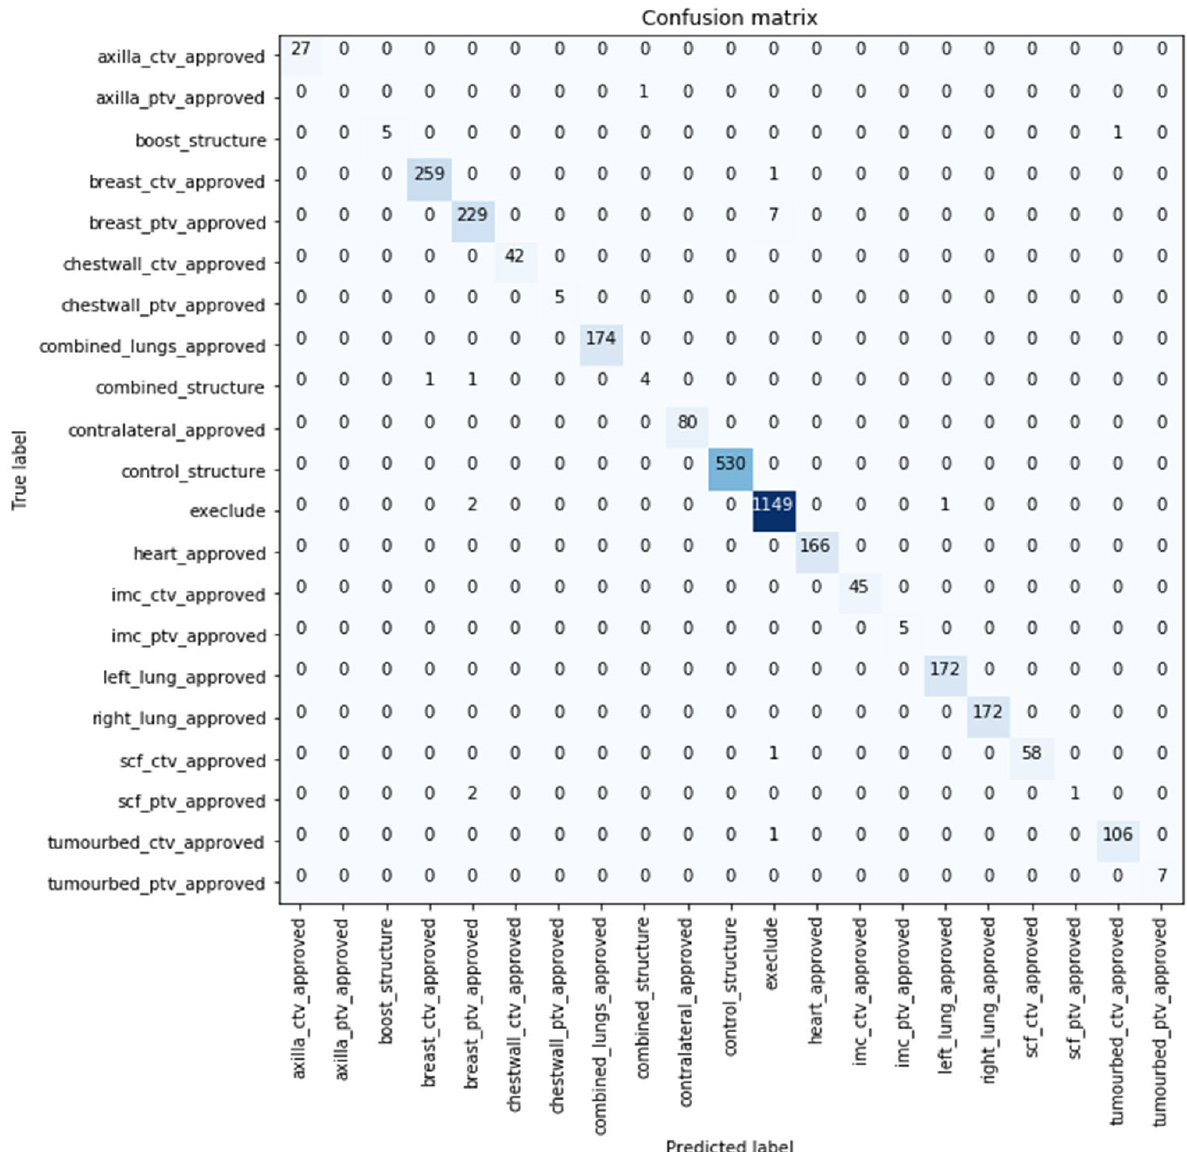
Figure 4. Confusion matrix of the best performing model in the extended test dataset.